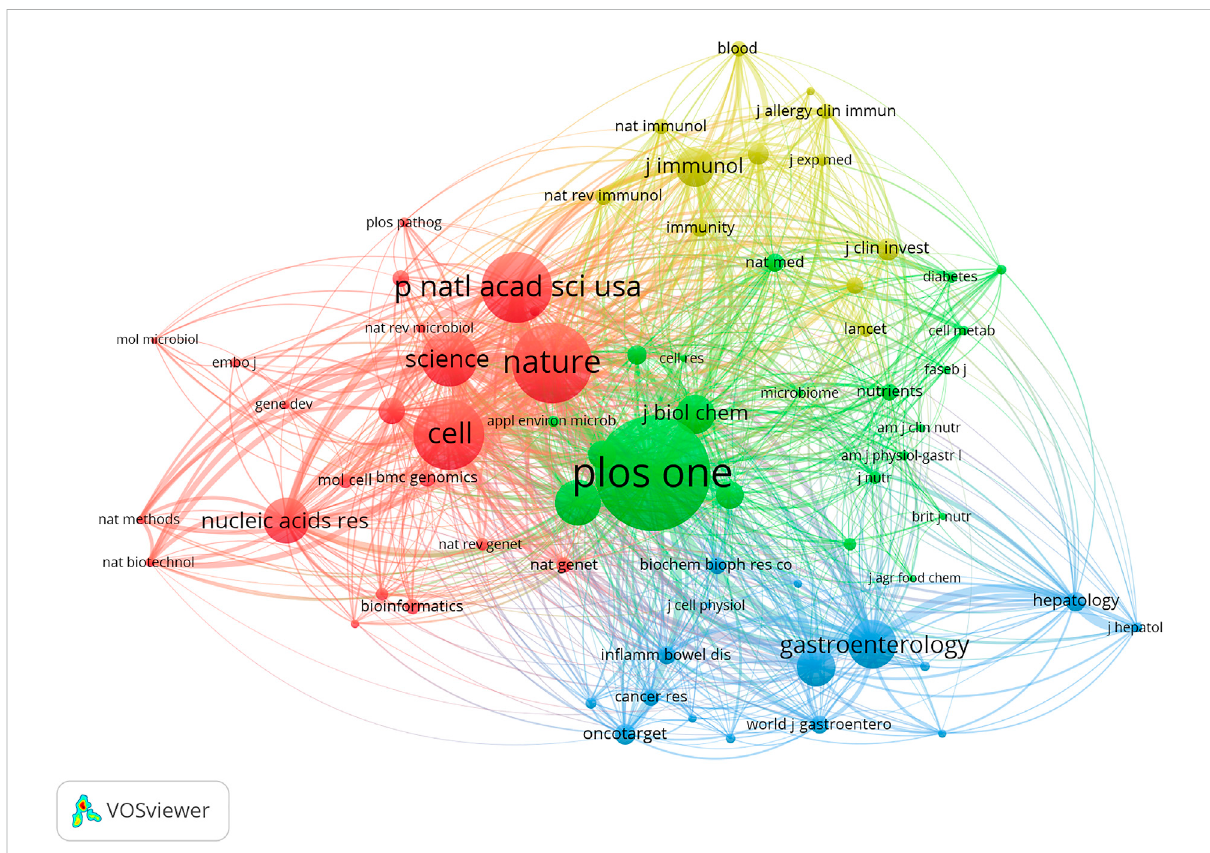
FIGURE 4 VOSviewer ’ snetwork analysis of co-cited journals with more than 50 publications. The node size represents the number of journal papers. The larger the node, the more journal papers.